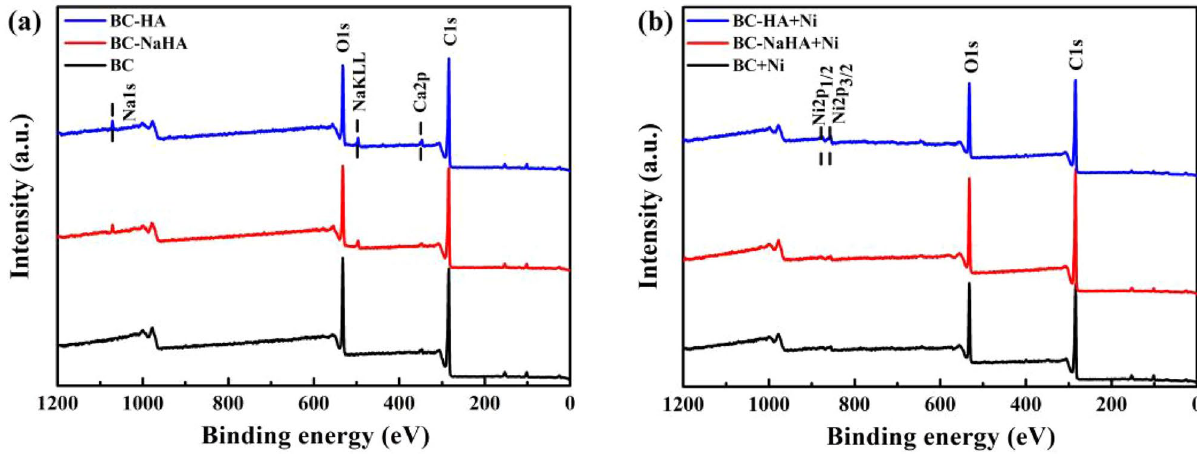
Figure 9. XPS spectra of ( a ) BC, BC-NaHA, BC-HA; ( b ) BC + Ni, BC-NaHA + Ni, BC-HA +